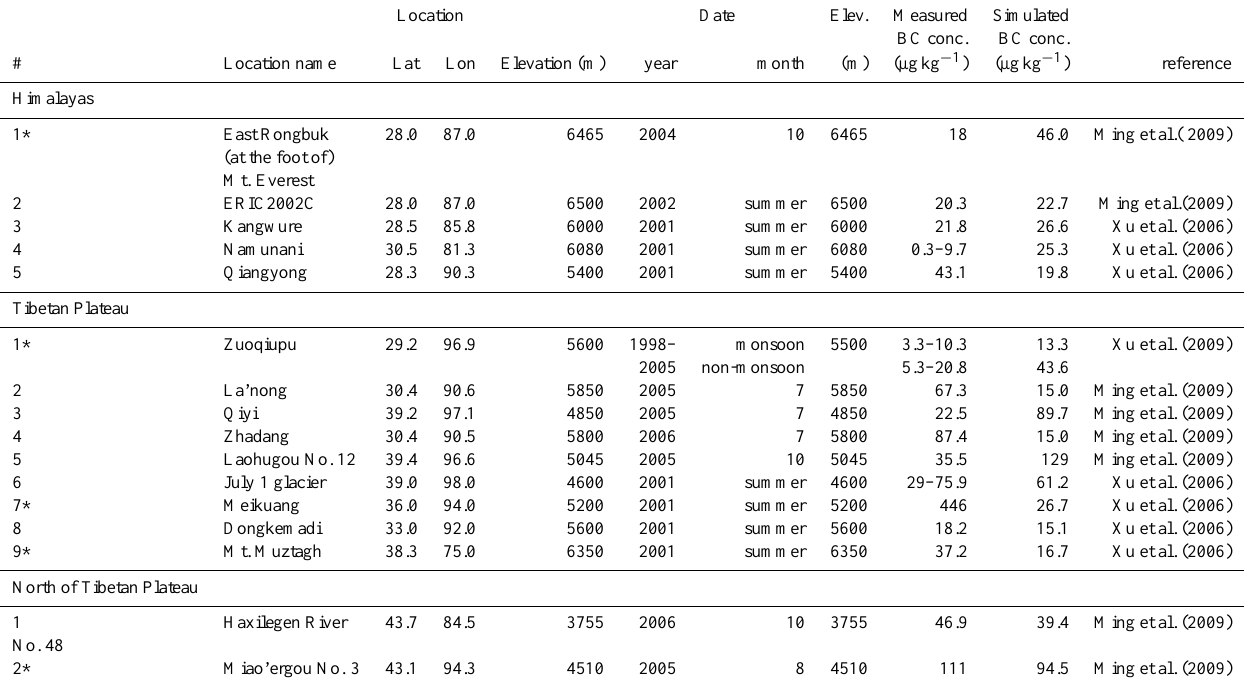
Table 1. Sites we focus on later in the paper are identified with an * in the first column. Location Date Elev. Measured Simulated BC conc.